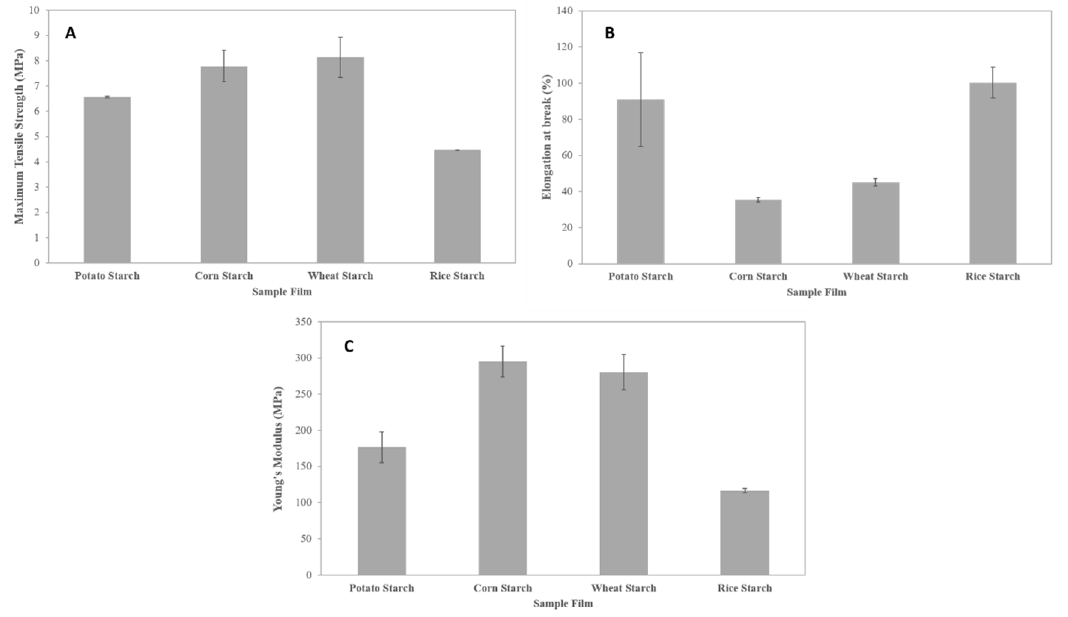
Figure8. Mechanicalpropertiesofthestarchfilmsstudied. ( A )Maximumtensilestrength; ( B )elongation Figure 8. Mechanical properties of the starch films studied. ( A ) Maximum tensile strength; ( B ) at break; and ( C ) Young’s elongation at break; and ( C ) Young’s modulus.